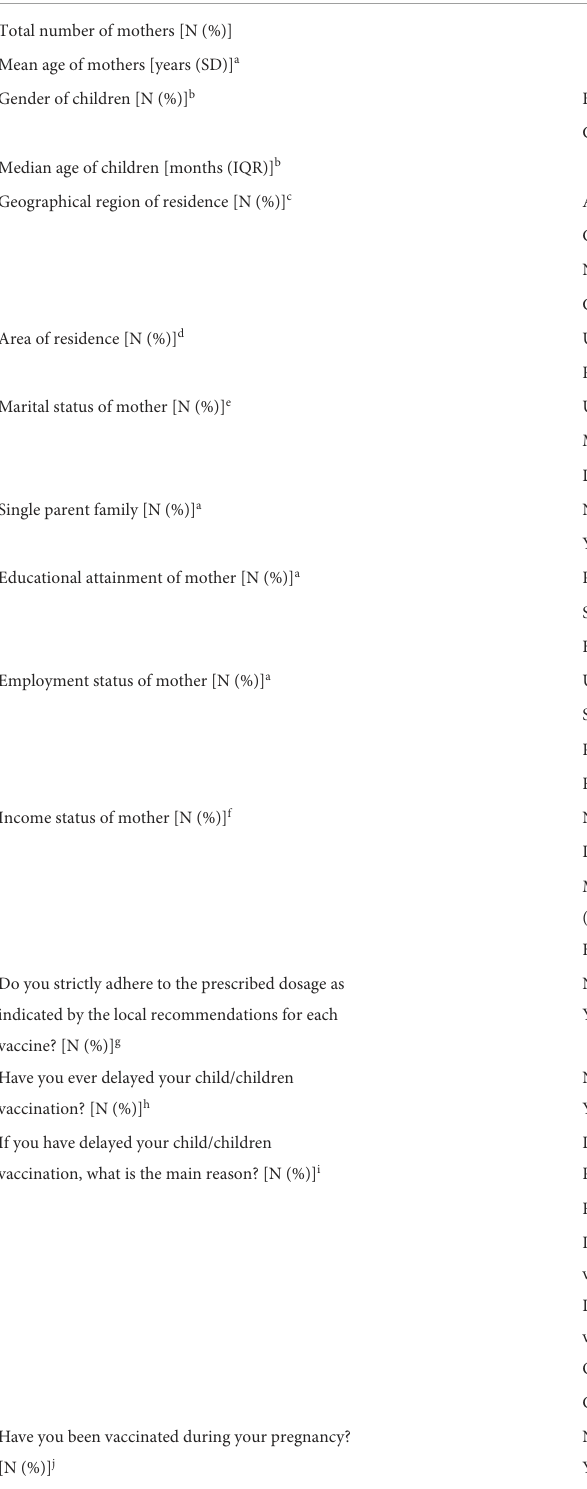
TABLE 1 Characteristics of the mothers and their children as well as previous vaccination behavior characteristics.